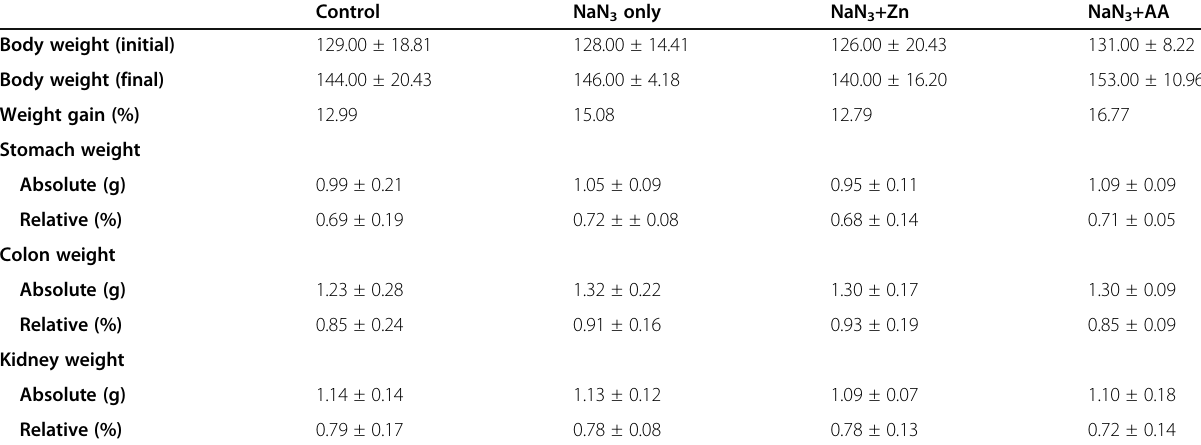
Table 1 Effect of treatments on body, stomach, colon and kidney weights Control